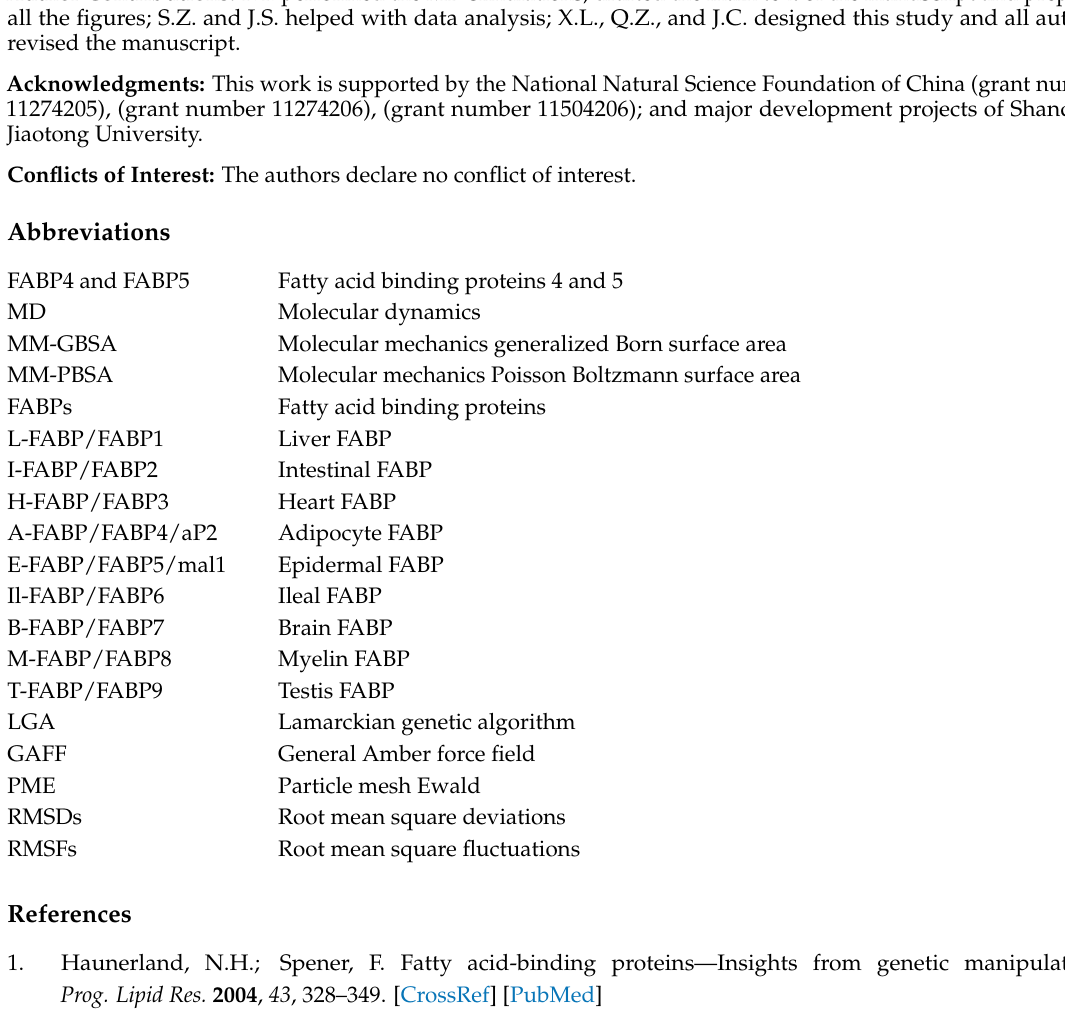
s1, Table S1. Comparison of energy contribution of individual component in inhibitor-FABP4 and inhibitor-FABP5 systems by MM-GBSA method a ; Table S2. Energy contribution of substituted residues in FABP4 and FABP5 calculated by MM-GBSA method a ; Figure S1. Superposition of conformations used in the experimental studies between inhibitor-FABP4 (yellow) and inhibitor-FABP5 (pink) complexes. (A) 5M7-FABP4/FABP5, (B) 65X-FABP4/FABP5, and (C) 65Z-FABP4/FABP5; Figure S2. Root-mean-square-deviations (RMSDs) of the backbone atoms in FABP4/FABP5 (A) and three inhibitors (B) relative to their starting structures during the MD simulation as function as time. Figure S3. Cross-correlation matrices of fluctuations of C α atoms relative to their average positions in six systems: (A1/A2) 5M7-FABP4/FABP5, (B1/B2) 65X-FABP4/FABP5, and (C1/C2) 65Z-FABP4/FABP5; Figure S4. Comparison of the eigenvalues plotted against the corresponding eigenvector indices originated from the diagonalization of covariance matrix of C α